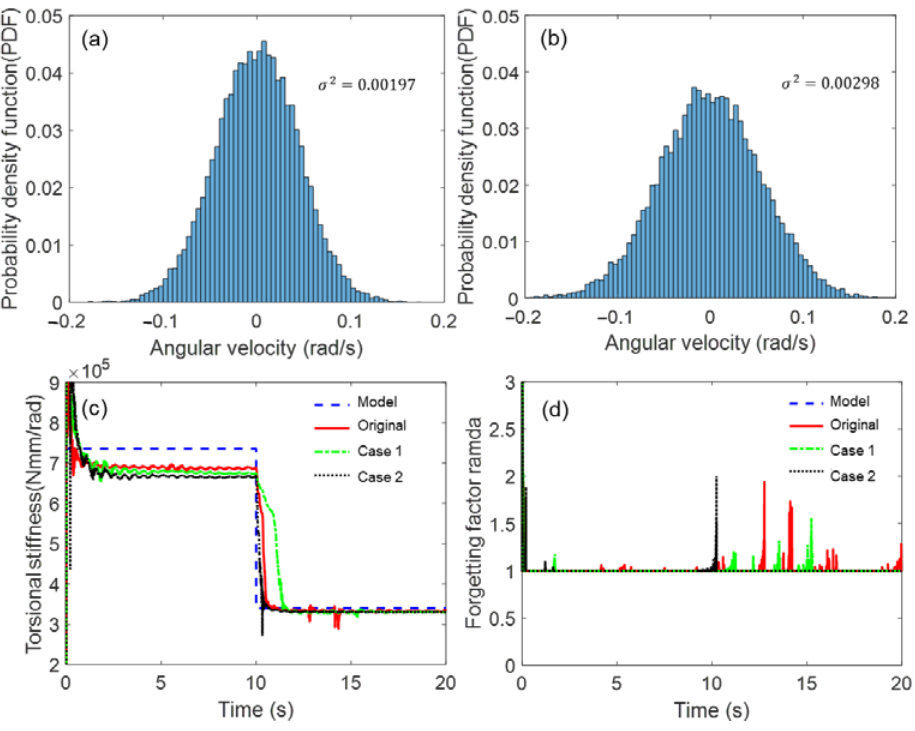
Figure 7. Simulation results of shaft stiffness estimation under noise uncertainty. Gaussian random distribution: ( a ) Case 1, and ( b ) Case 2, ( c ) torsional shaft stiffness, ( d ) forgetting factor.